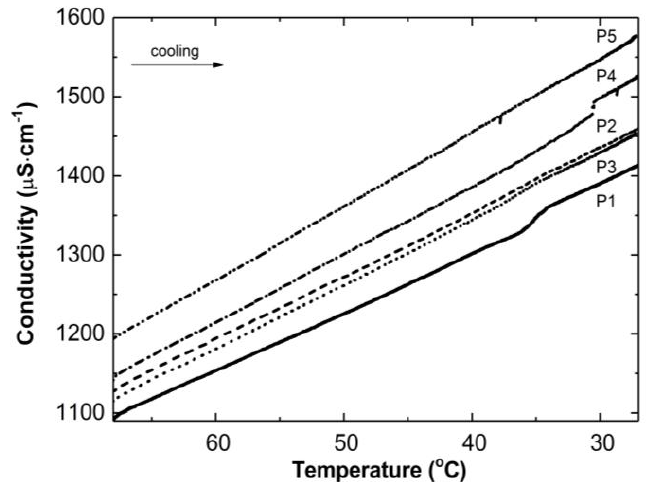
Figure 3. Conductivity changes as a function of temperature in the post-reaction mixtures of P1–P5 during cooling procedure.